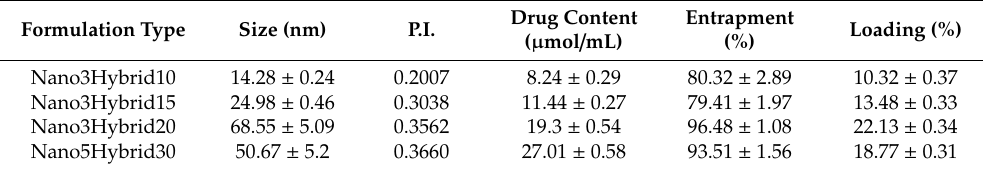
Table 2. Properties of nanomicelles in terms of size and drug content.